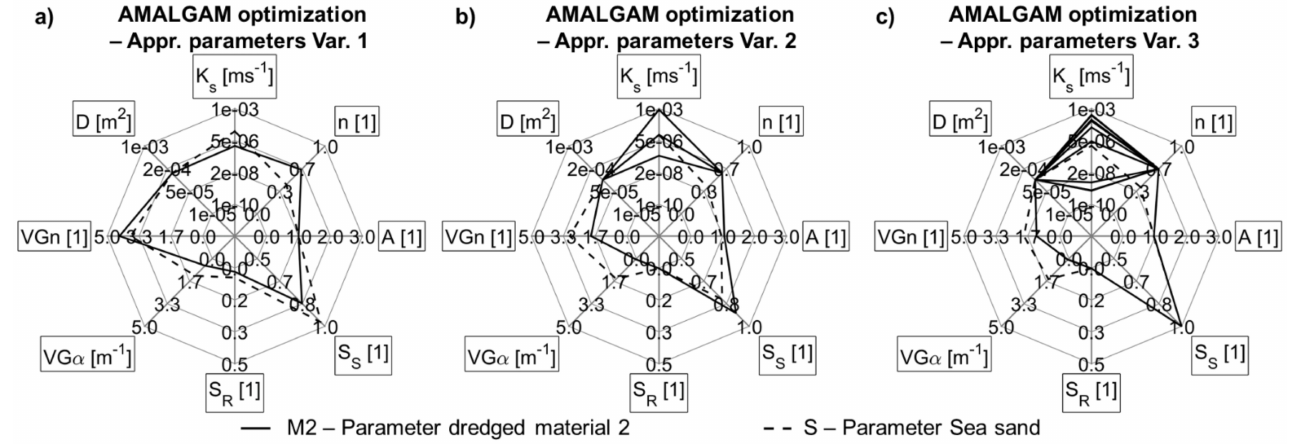
Figure 12. Estimated parameters of the AMALGAM approximation for ( a ) Var. 1, ( b ) Var. 2 and ( c ) Var.